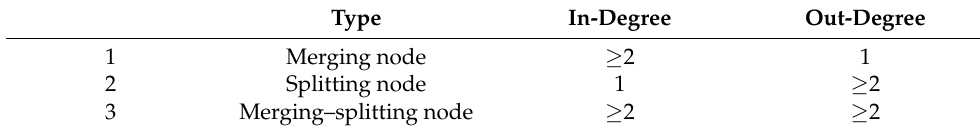
Table 1. Relationship between type of linked node and its in-degree and out-degree.